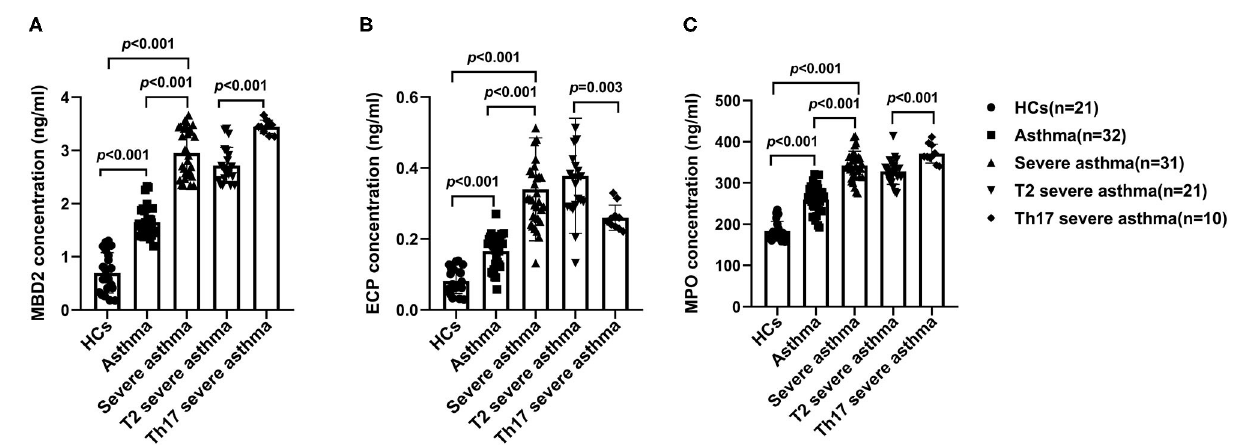
FIGURE 2 | Serum MBD2, ECP and MPO levels in the different groups. MBD2 (A) , ECP (B) and MPO (C) levels were compared for HCs and patients with asthma, severe asthma, T2 severe asthma and Th17 severe asthma. Comparisons among the groups were performed by Kruskal-Wallis test followed by Dunn’s